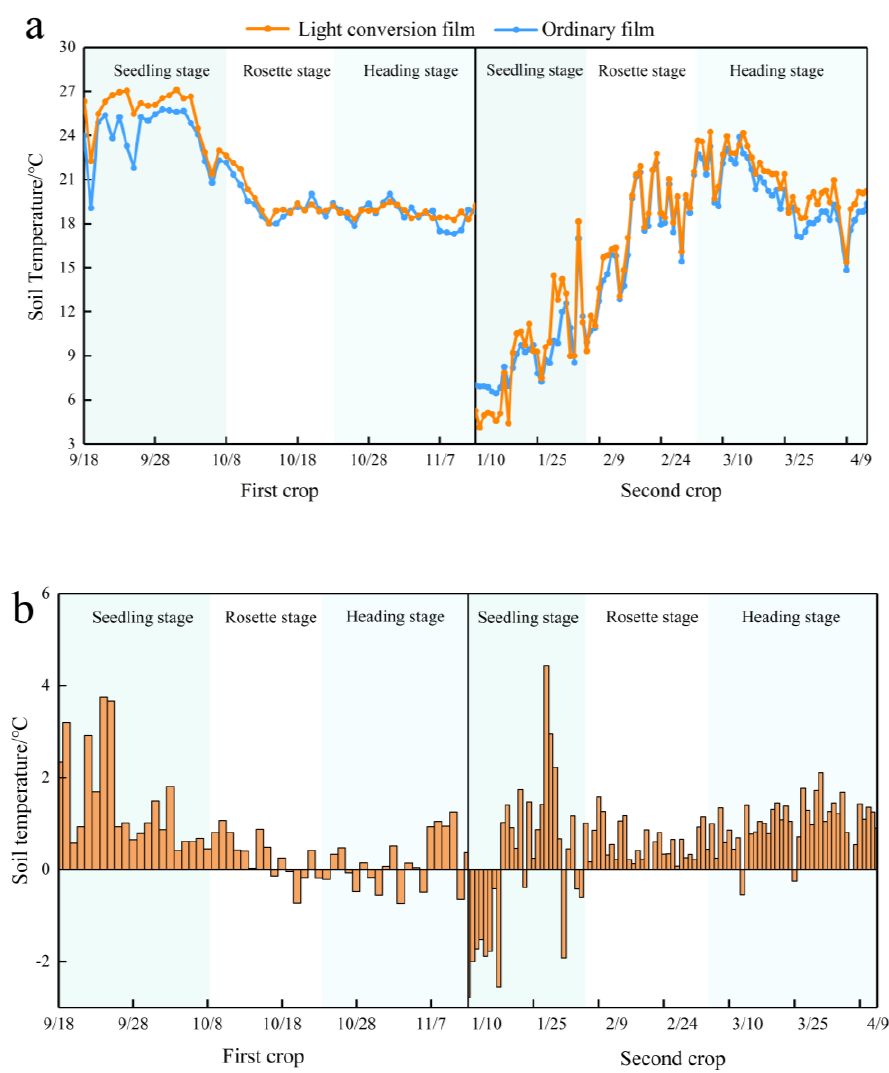
Figure 9. Effects of light conversion film (LCF) and ordinary film (OF) on soil temperature in greenhouse under different crops. ( a ) Indicates the daily average soil temperature change in the greenhouse environment under light conversion film and ordinary film. ( b ) Variable representing the difference between daily average soil temperature of light conversion films and ordinary films.